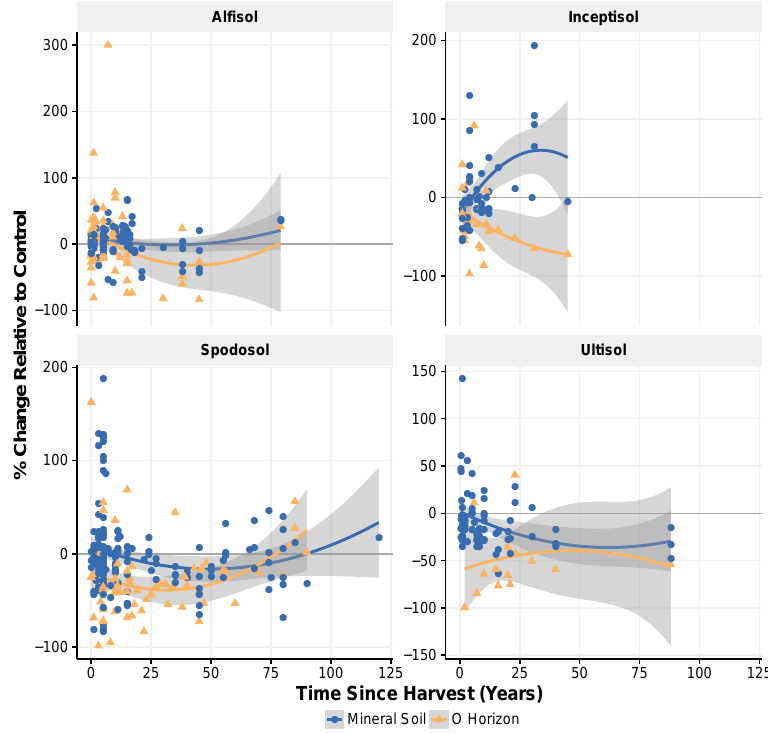
Figure 5. Temporal patterns in both O horizon (yellow triangle) and mineral soil (blue circle) C pools for Alfisol, Inceptisol, Spodosol, and Ultisol orders. Other soil orders are not shown due to an inadequate number of response ratios over time. Regression lines show trends with time using a second order polynomial. For the overall model, F = 9.205 on 7 and 532 degrees of freedom, Adj. R 2 = 0.096, and p < 0.0001 (Table